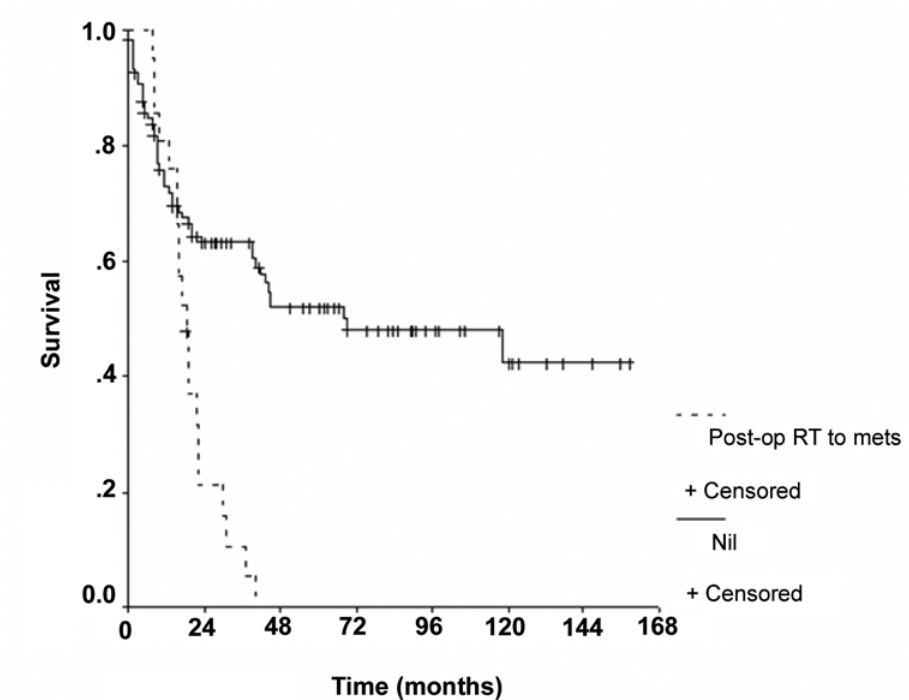
Figure 7 – Disease specific survival by postoperative radiotherapy to distant metastasis.